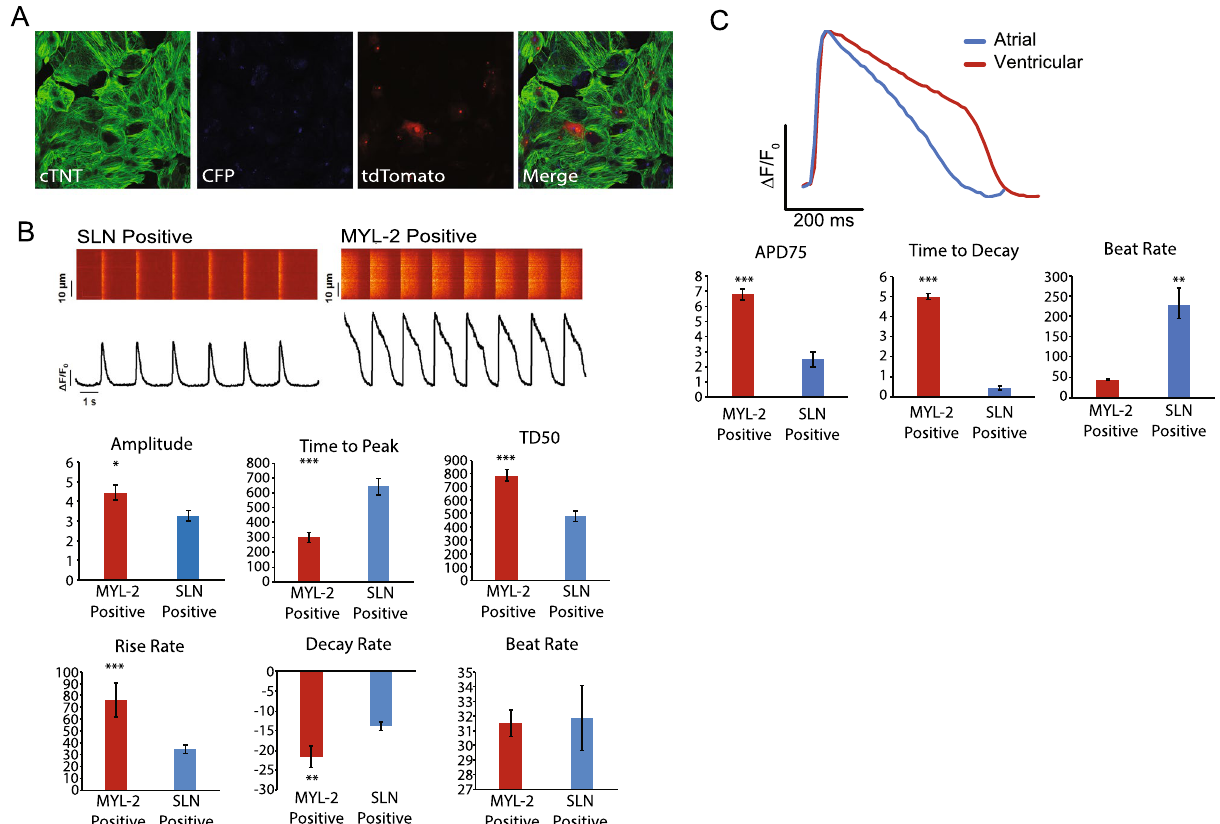
Figure 5. Characterization of the atrial/ventricular human iPSC Double Reporter Line. ( A ) Representative immunofluorescence images of day 30 cardiomyocytes from the double reporter system, MYL-2/tdTomato (red) and SLN/eCFP (cyan), immunostained for cTNT (green). ( B ) Representative calcium tracing and quantification of amplitude, time to peak, TD50, rise rate, decay rate, and beat rate of MYL-2/tdTomato (+) and SLN/eCFP(+) cells (day 30) from the double reporter system. ( C ) Representative action potential tracing of MYL-2/tdTomato (+) and SLN/eCFP(+) cells (day 30) from the double reporter system separately using voltage activated fluorescent dye and quantification of APD75, decay rate, and beat rate of MYL-2/tdTomato (+) and SLN/ eCFP(+) cells (day 30) from the double reporter